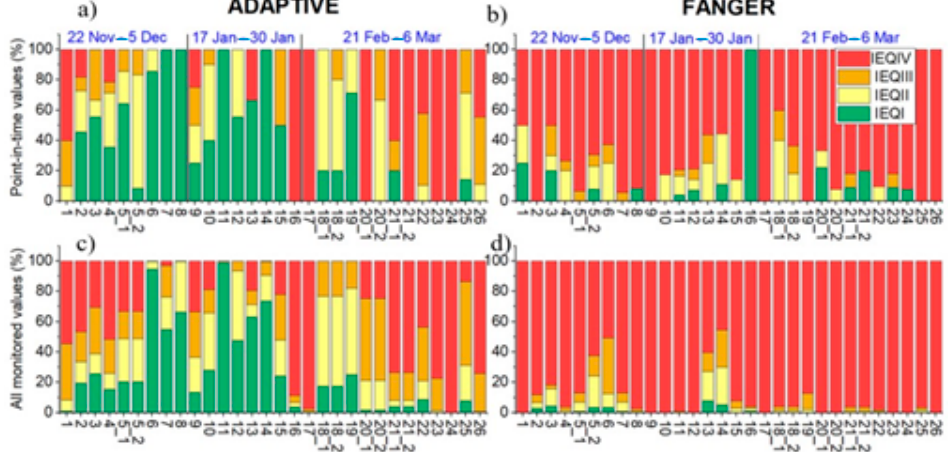
Figure 10. Adaptive Thermal Comfort IEQ levels ( a , c ). Fanger Thermal Comfort IEQ levels ( b , d ). Point-in-time monitored values ( a , b ), for Fanger clothing factor (clo) is calculated according to answers. All monitored values ( c , d ), for Fanger clothing factor (clo) is estimated constant and equal to 1.0.